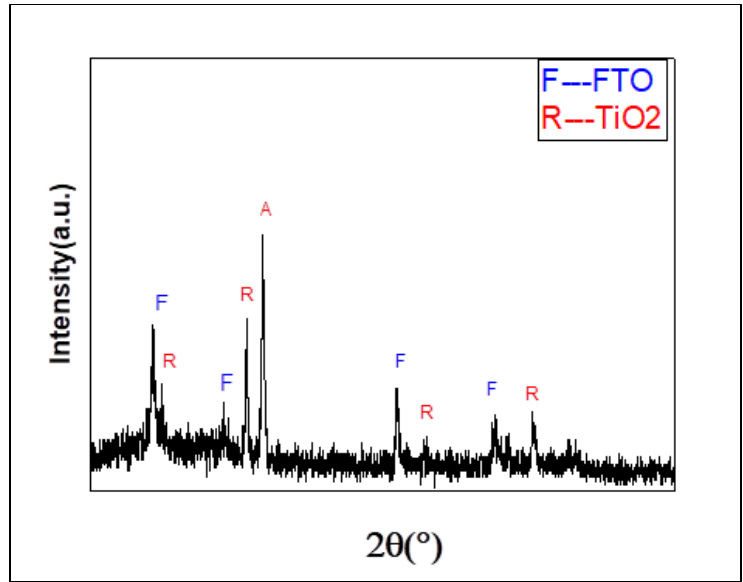
Figure 3. XRD pattern of TiO NRs film prepared on FTO by hydrothermal method at 180 o C for 2